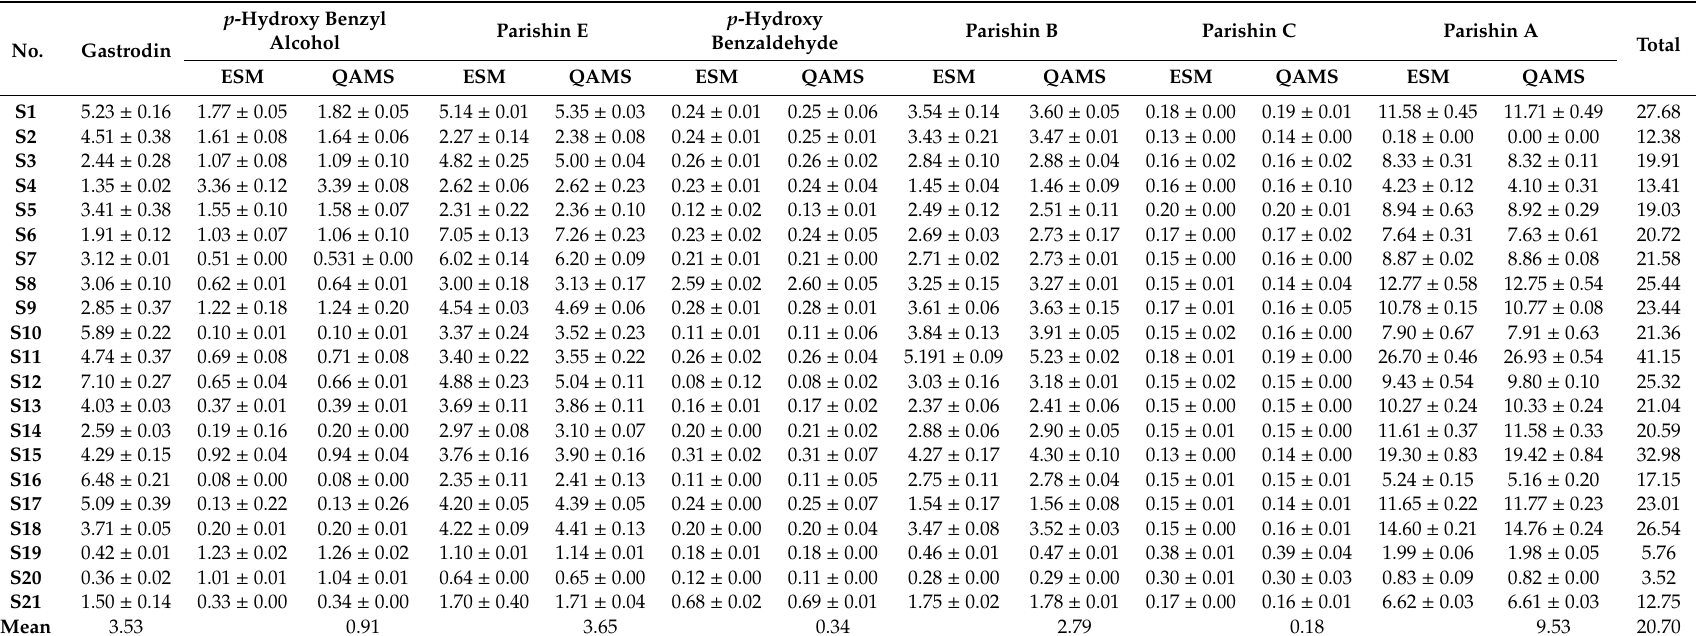
Table 6. Contents of the seven components in G. elata tubes determined by the external standard method (ESM) and the quantitative analysis of multi-components by single marker (QAMS) methods (mg · g -1 ) 1